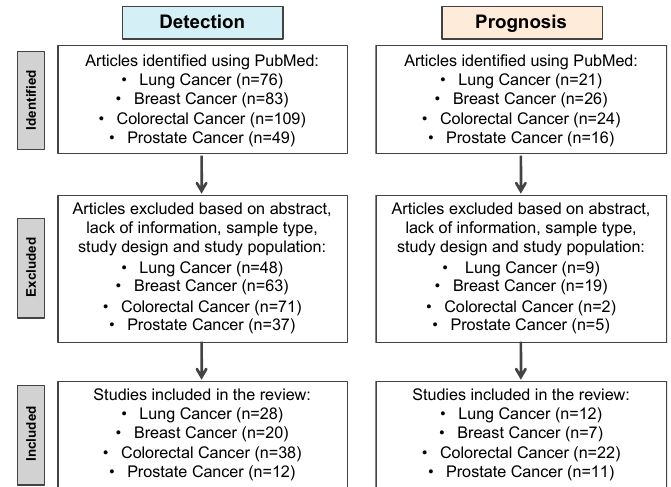
Figure 2. Flow diagram of Pubmed available studies’ selection procedure using the key words “Lung Cancer/Breast Cancer/Colorectal Cancer/Lung Cancer”, “DNA methylation”, “Diagnosis/Detection/Prognosis” and “Serum/Plasma”.